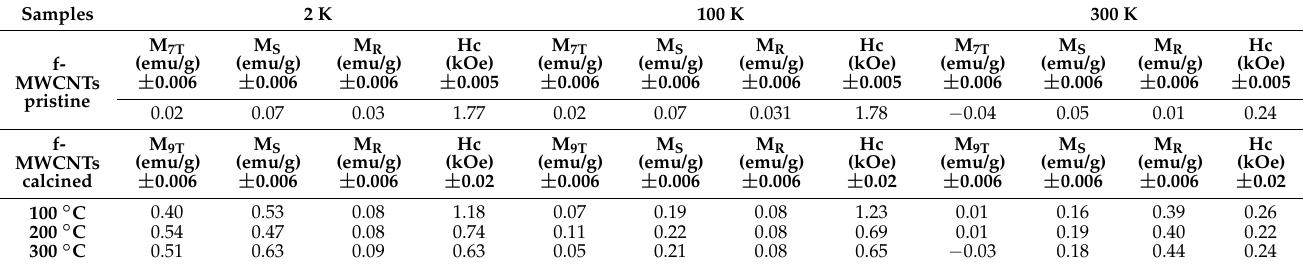
Table 2. Magnetic properties of pristine and calcined